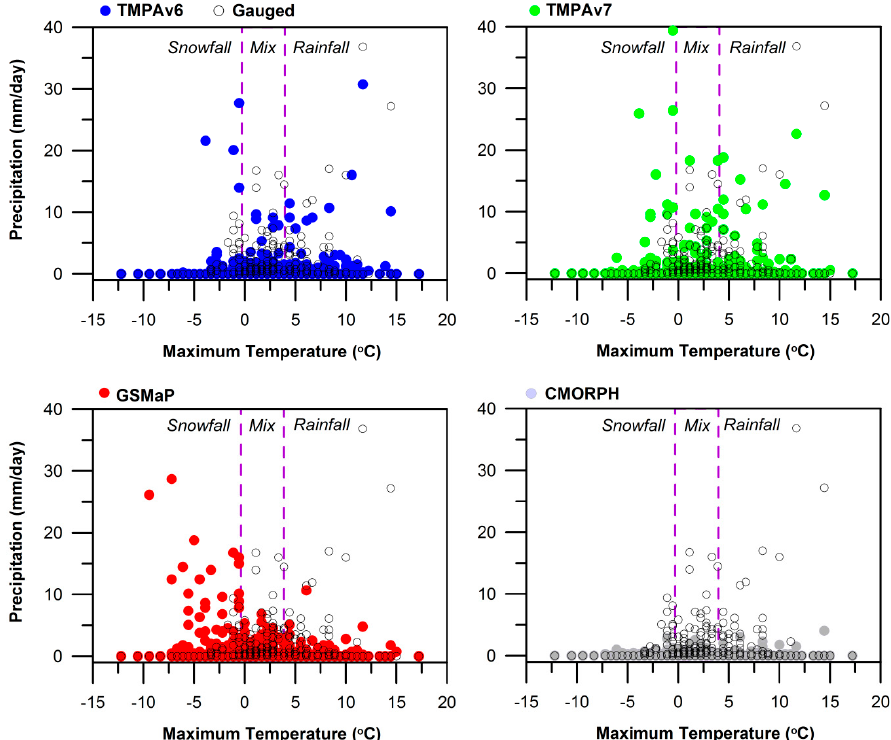
Figure 9. Scattergrams of daily basin-averaged precipitation and maximum temperature during winter (December, January, and February). The dashed line indicates the utilized temperature thresholds for snowfall (0.39 °C, tmax_allsnow ) and rainfall (3.9 °C, tmax_allrain ) within the PRMS hydrologic model.